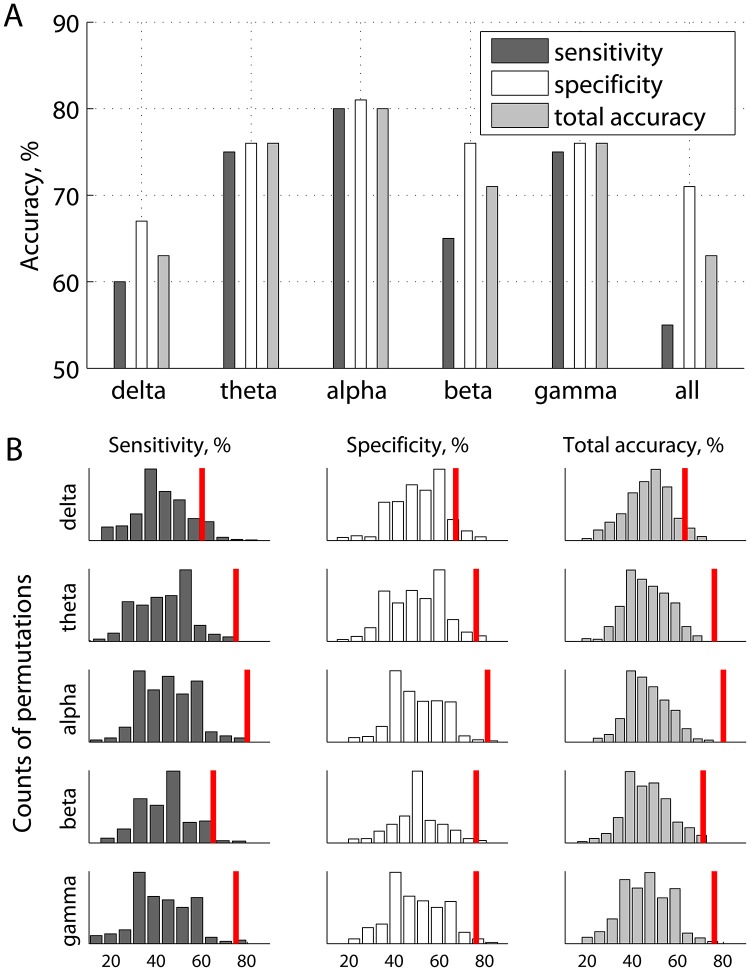
Prediction accuracies of classification as functions of frequency bands, wherein individual wavelet frequencies were grouped into 5 subsets (A), and corresponding accuracies of classification based on randomized labels representing presence or absence of mTBI (B).The red marks in panel B represent the same accuracies as in panel A.